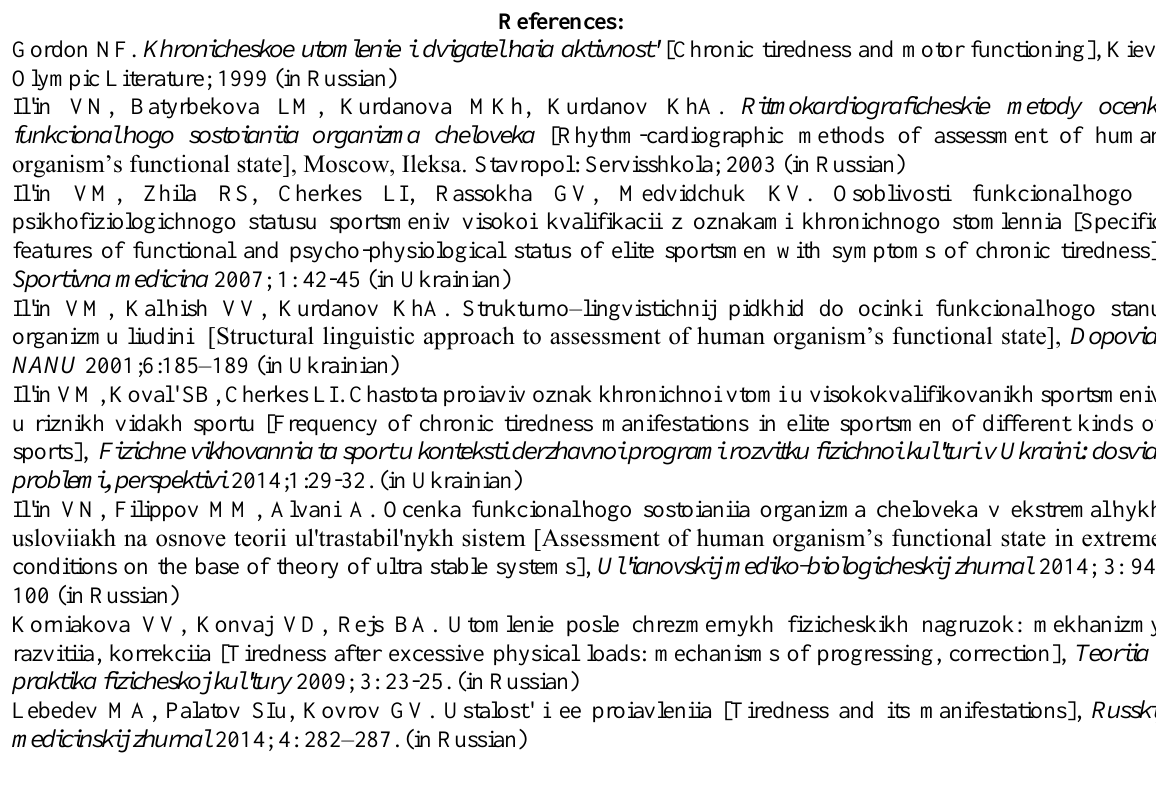
Fig.4. Distribution of optimal (SOT - Sm, SmSb, SmSbSf, Sb, SbSm, SbSmSf), functional (SFL - SmSfSb, SbSfSm) tension and over tension (SOVT - SfSm, SfSmSb ) of regulatory mechanisms in rest and after AFL of sportsmen with CT